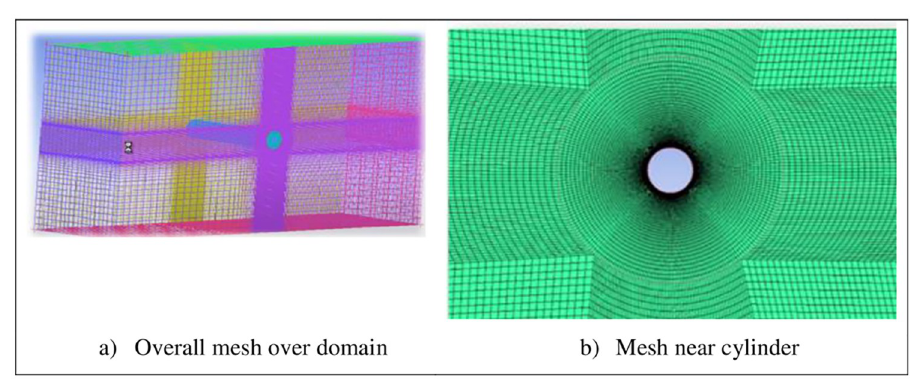
Fig 2. Mesh details.